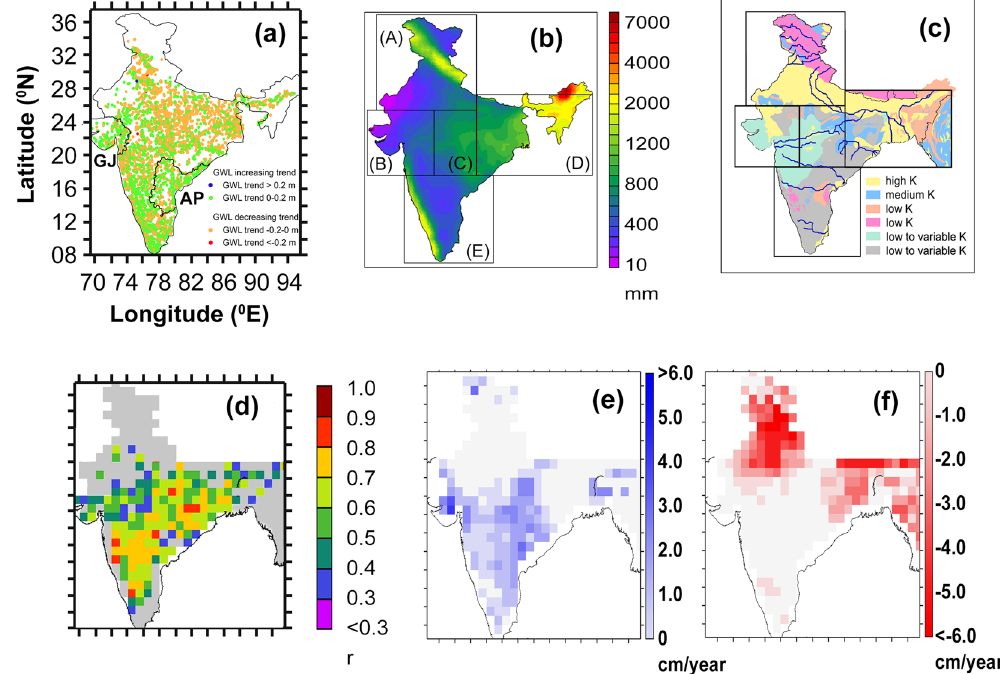
Figure 1. ( a ) The study area including groundwater level (GWL) trend (calculated based on culled, temporally continuous groundwater level measurements [n = 4316] between 1996 and 2014); ( b ) annual mean precipitation (mm/year) between 1979 and 2014. Rectangular outlines indicate the five hydro-meteorological zones (A to E) delineated based on the duration of the hydro-meteorological seasons (monsoon, post-monsoon and pre-monsoon); ( c ) map of different aquifer types, classified based on hydraulic conductivity (K). Major rivers are marked by blue lines; ( d ) map of significant correlation coefficient (r, p value 0.05) between GWS obs and GWS sat ; Maps of trends of ( e ) positive (blue), and ( f ) negative (red) GWS sat anomalies, respectively. All the maps were made using Ferret program (NOAA), QGIS software 47 and standard graphical